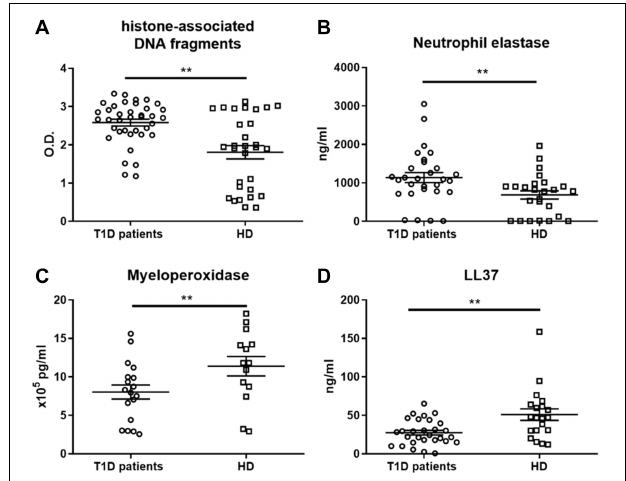
FIGURE 3 | NET-associated product quantification in neutrophil extracellular traps. (A) Levels of histone-associated DNA fragments, (B) neutrophil elastase (NE), (C) myeloperoxidase (MPO) and (D) LL37 in NET fragments of T1D patients (56–65% female) and healthy donors (56–68% female), detected by ELISAs were analyzed in 14, 29 or 38 T1D patients and 14, 20 or 30 HD respectively. Statistical analysis was performed using unpaired t -tests. Values of p < 0.01 (**) were considered statistically